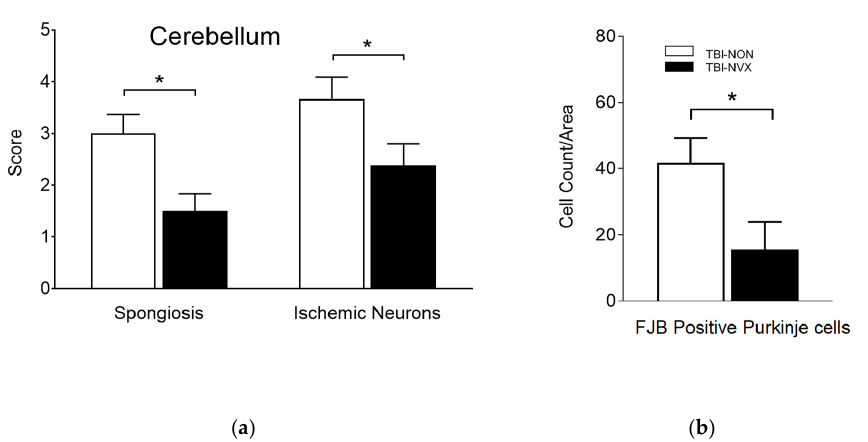
Figure 6. Regional area and severity score for cells stained with Fluoro-Jade B: cerebellar injury scores and cell counts. ( a ) Injury scores for spongiosis and ischemic/dead neurons and ( b ) cell counts (right panel, for Fluoro-Jade B positive Purkinje cells. Mean ± SEM; * p < 0.05 significant difference between treatment groups.